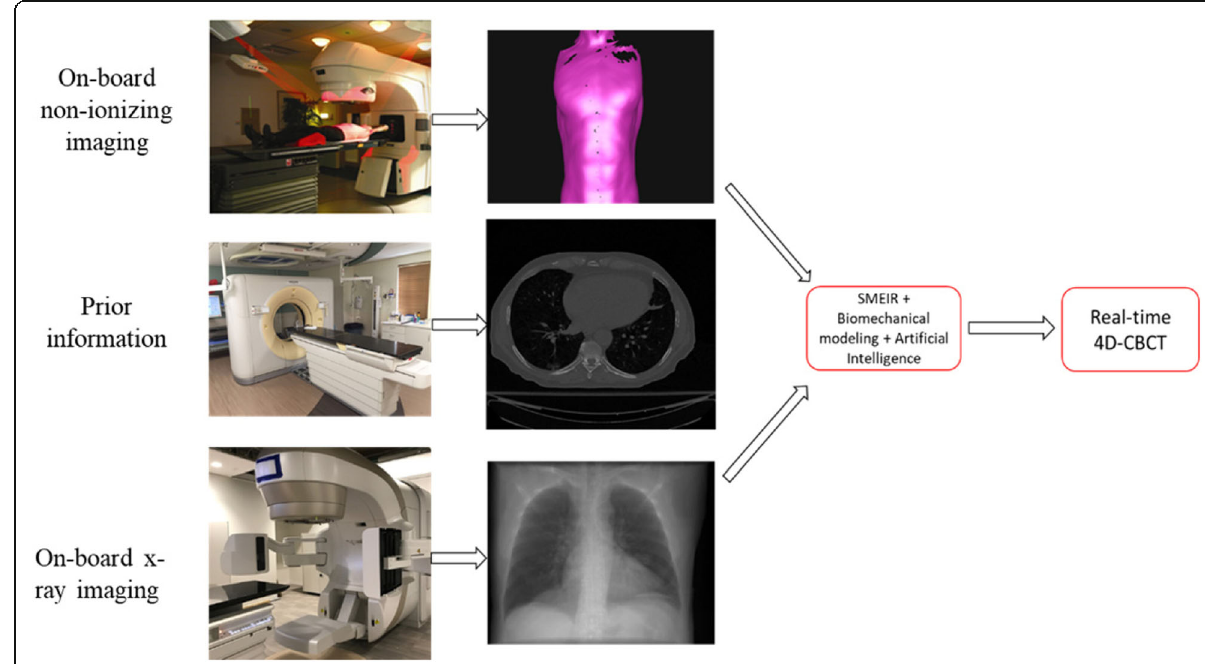
Fig. 8 The envisioned future developments towards real-time 4D-CBCT imaging, by combining real-time on-board information provided by non-ionizing imaging signals including the optical surface imaging, and prior information (prior CT/CBCT, prior motion model), and real-time on-board x-ray imaging. Through combining all these information sources, a reconstruction system comprising SMEIR, biomechanical modeling, and AI could potentially achieve real-time imaging to guide the most accurate treatment delivery, and allow on-the-fly plan adjustment to fit the patients ’ daily variations. 4D-CBCT: 4- Dimensional cone-beam computed tomography; SMEIR: Simultaneous motion estimation and image reconstruction; AI: Artificial intelligence